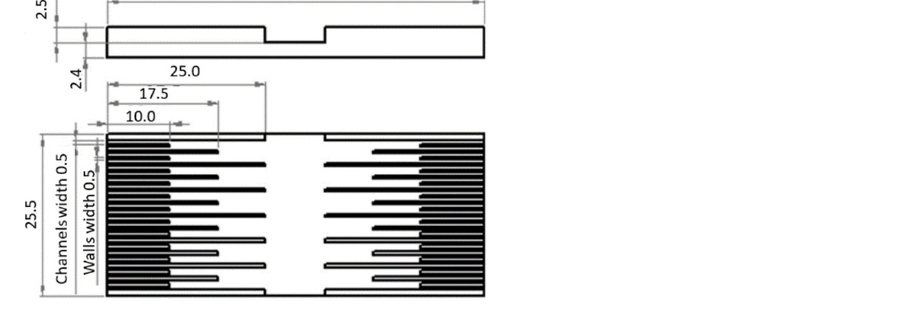
Figure 30. Hybrid cooling device (dimensions in mm) [67]. Reprinted with permission from Ref. [67]. 2014, Elsevier.